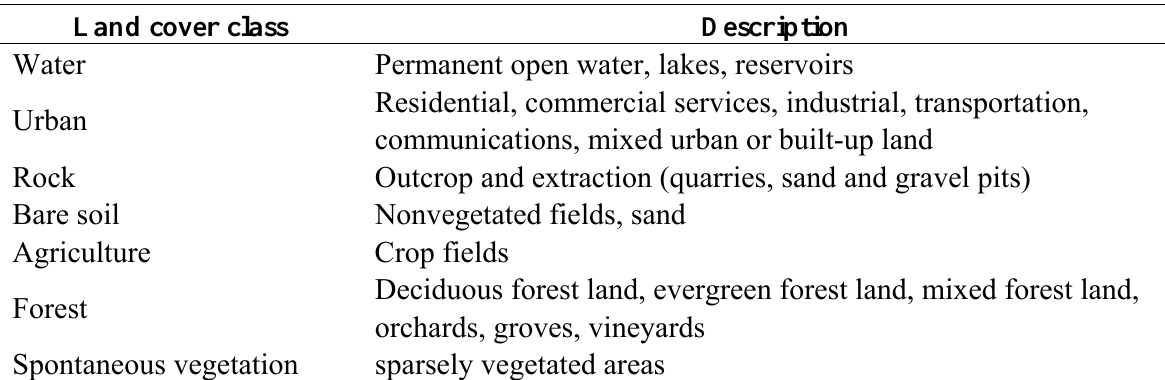
Table 1. Land cover classification